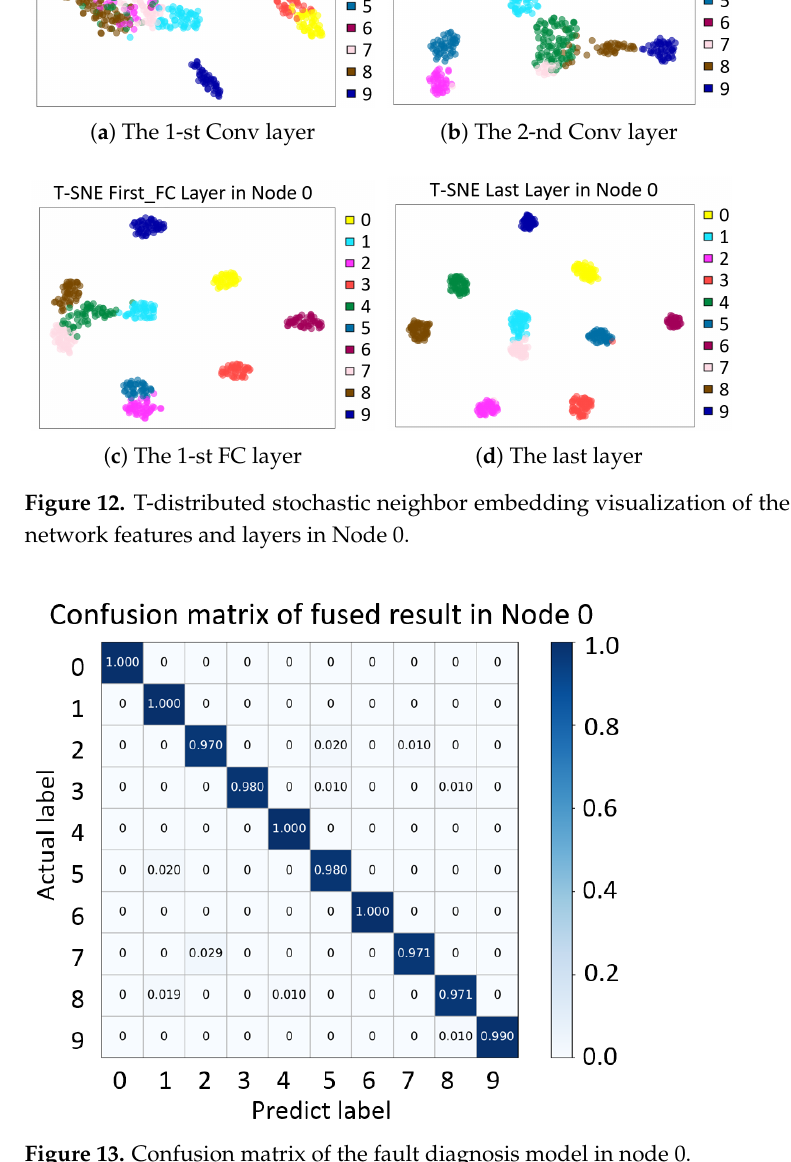
Figure 13. Confusion matrix of the fault diagnosis model in node